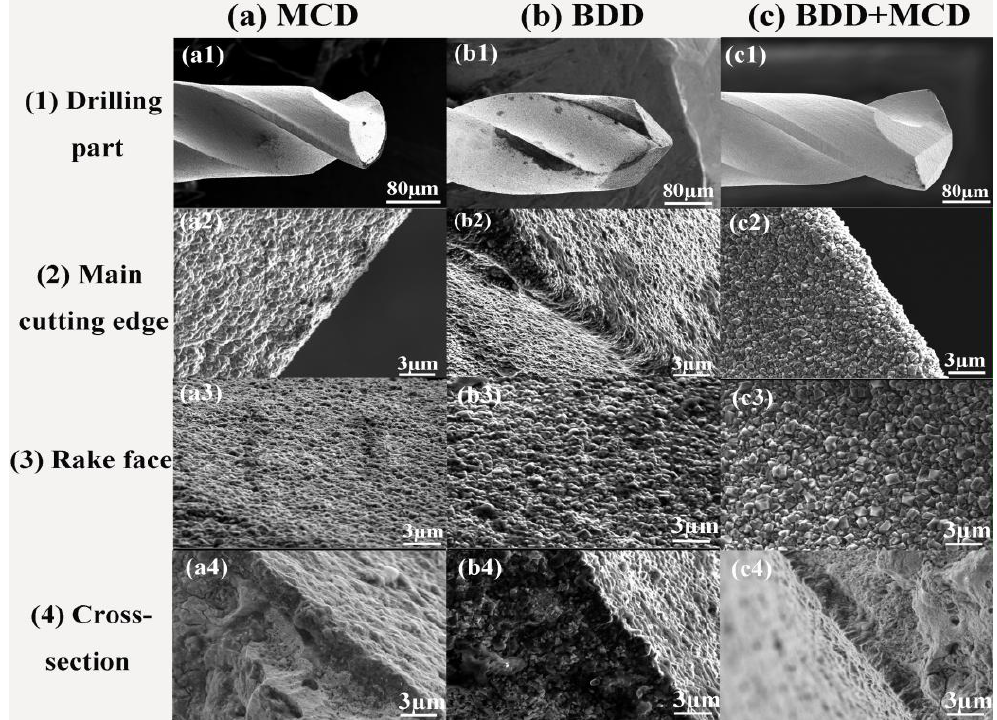
Figure 2. Field emission scan electron microscopy (FE-SEM) images of as-fabricated